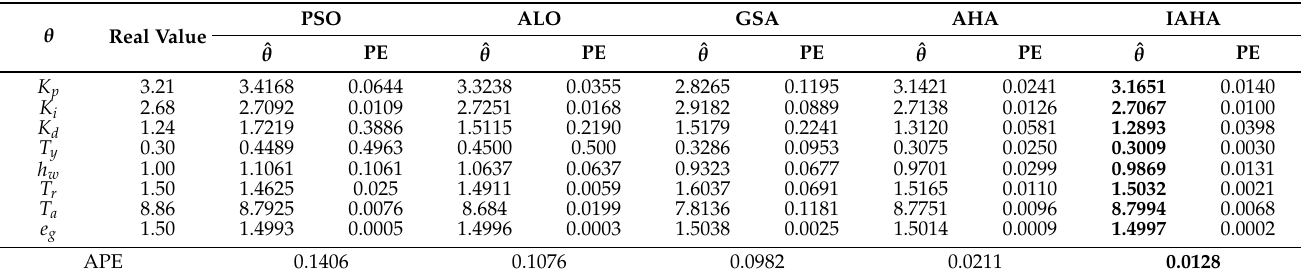
Table 7. Algorithm identification results of 15% frequency disturbance.